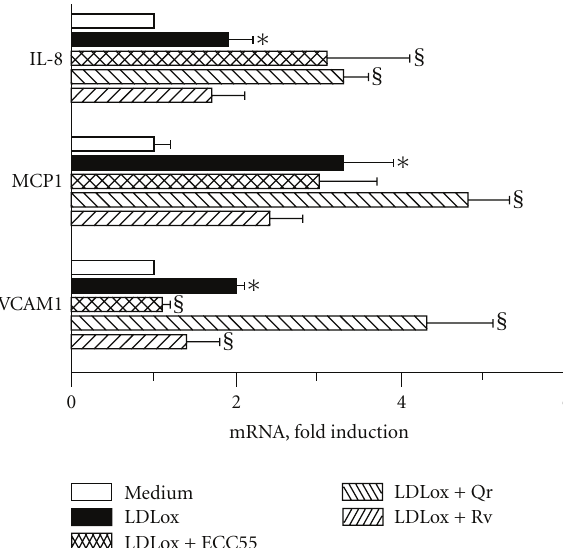
Figure 6: E ff ects of concentrated ethanol extract of Edelweiss callus cultures (ECC55) and reference anti-inflammatory plant polyphe- nols on inflammatory gene expression in human umbilical vein endothelial cells (HUVECs) challenged with oxidized human low- density lipoprotein (LDLox). Abbreviations are as in Figure 5. Error bars in all figures correspond to S.D. ∗ P < 0.01 versus untreated keratinocytes; § P < 0.05 versus LDLox-treated